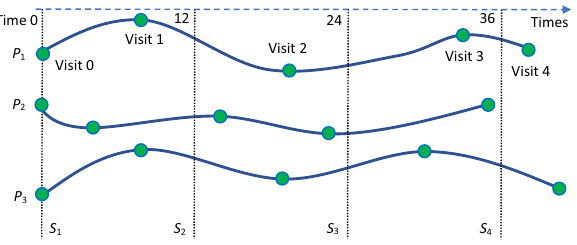
Fig. 15 The relative visit times for three patients p 1 , p 2 , and p 3 for snapshots S 1 to S 4 based on these visit